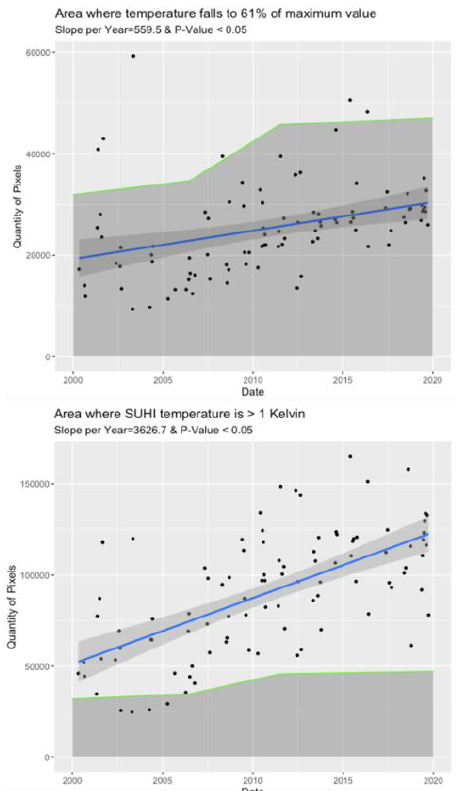
Figure 4 . The size of both SUHI thresholds from each acquired image. The total quantity of urban pixels within Urban Milton (green) and the line of regression (blue) are presented to compare planar surface SUHI threshold results with actual urban